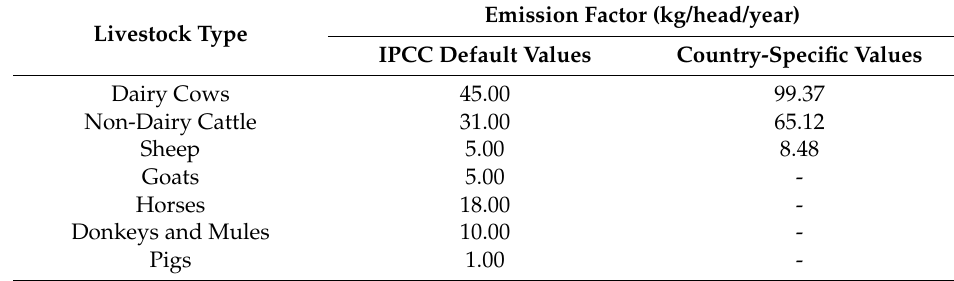
Table 2. Enteric methane emission factors for IPCC (Intergovernmental Panel on Climate Change) livestock categories